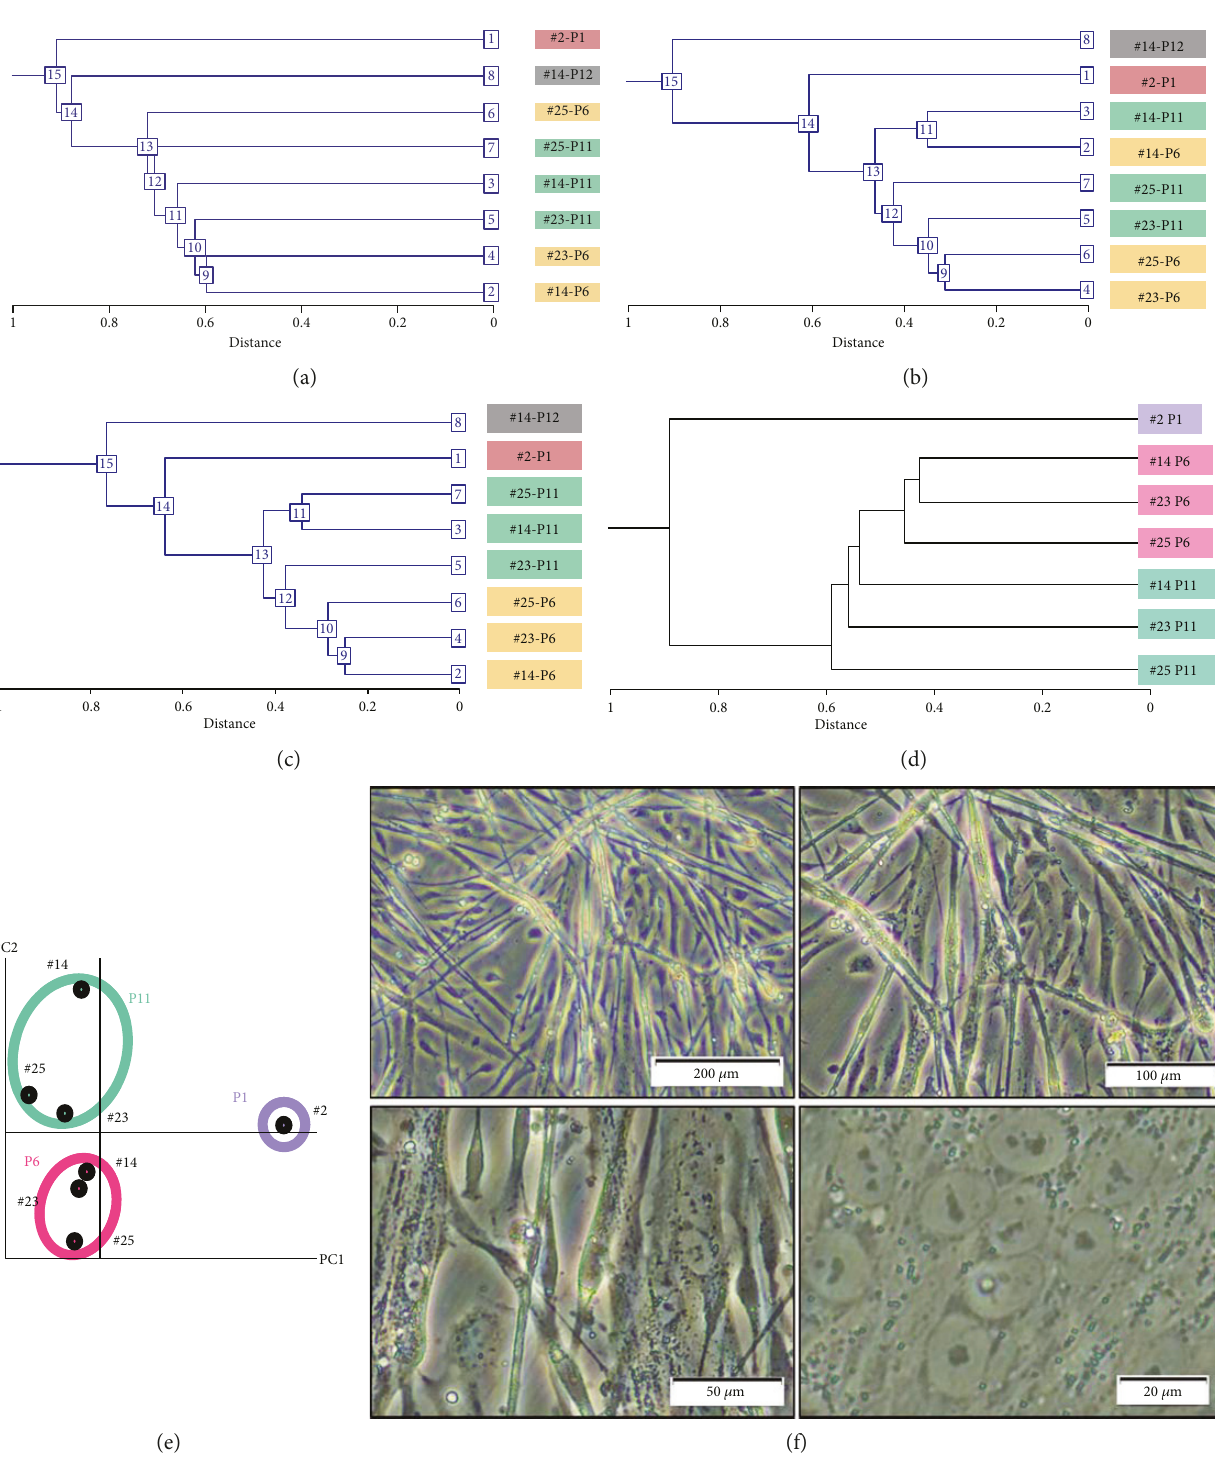
Figure 4: Global gene expression analysis of ESC-derived mesenchymal stromal cells. (a) Hierarchical clustering analysis based on the expression of all genes (58,201 probes on an Agilent SurePrint G3 Human GE v3 8x60K Microarray). (b) Hierarchical clustering analysis based on expression levels of the mesenchyme-associated genes. (c) Hierarchical clustering analysis based on expression levels of the stem cell-associated genes. (d) Hierarchical clustering analysis based on expression levels of the muscle-associated genes. (e) Principal component analysis of the muscle-associated genes. (f) Phase-contrast photomicrographs of knst